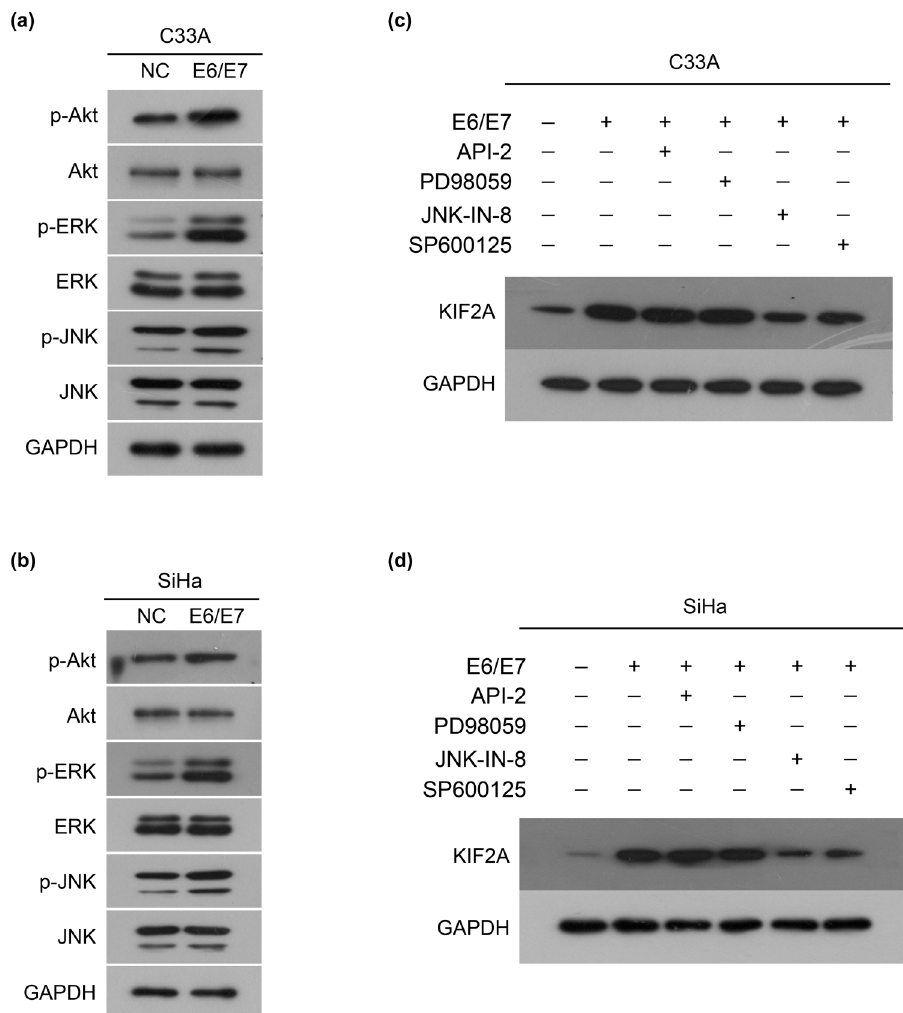
Figure 3: HPV16 E6E7 up - regulates KIF2A expression by activating JNK. Exogenous expression of E6/E7 in C33A ( a ) and SiHa ( b ) cells increased the phosphorylation of Akt, ERK, and JNK. E ff ect of Akt, ERK, and JNK inhibitors in KIF2A expression induced by E6/E7 in C33A ( c ) and SiHa ( d )